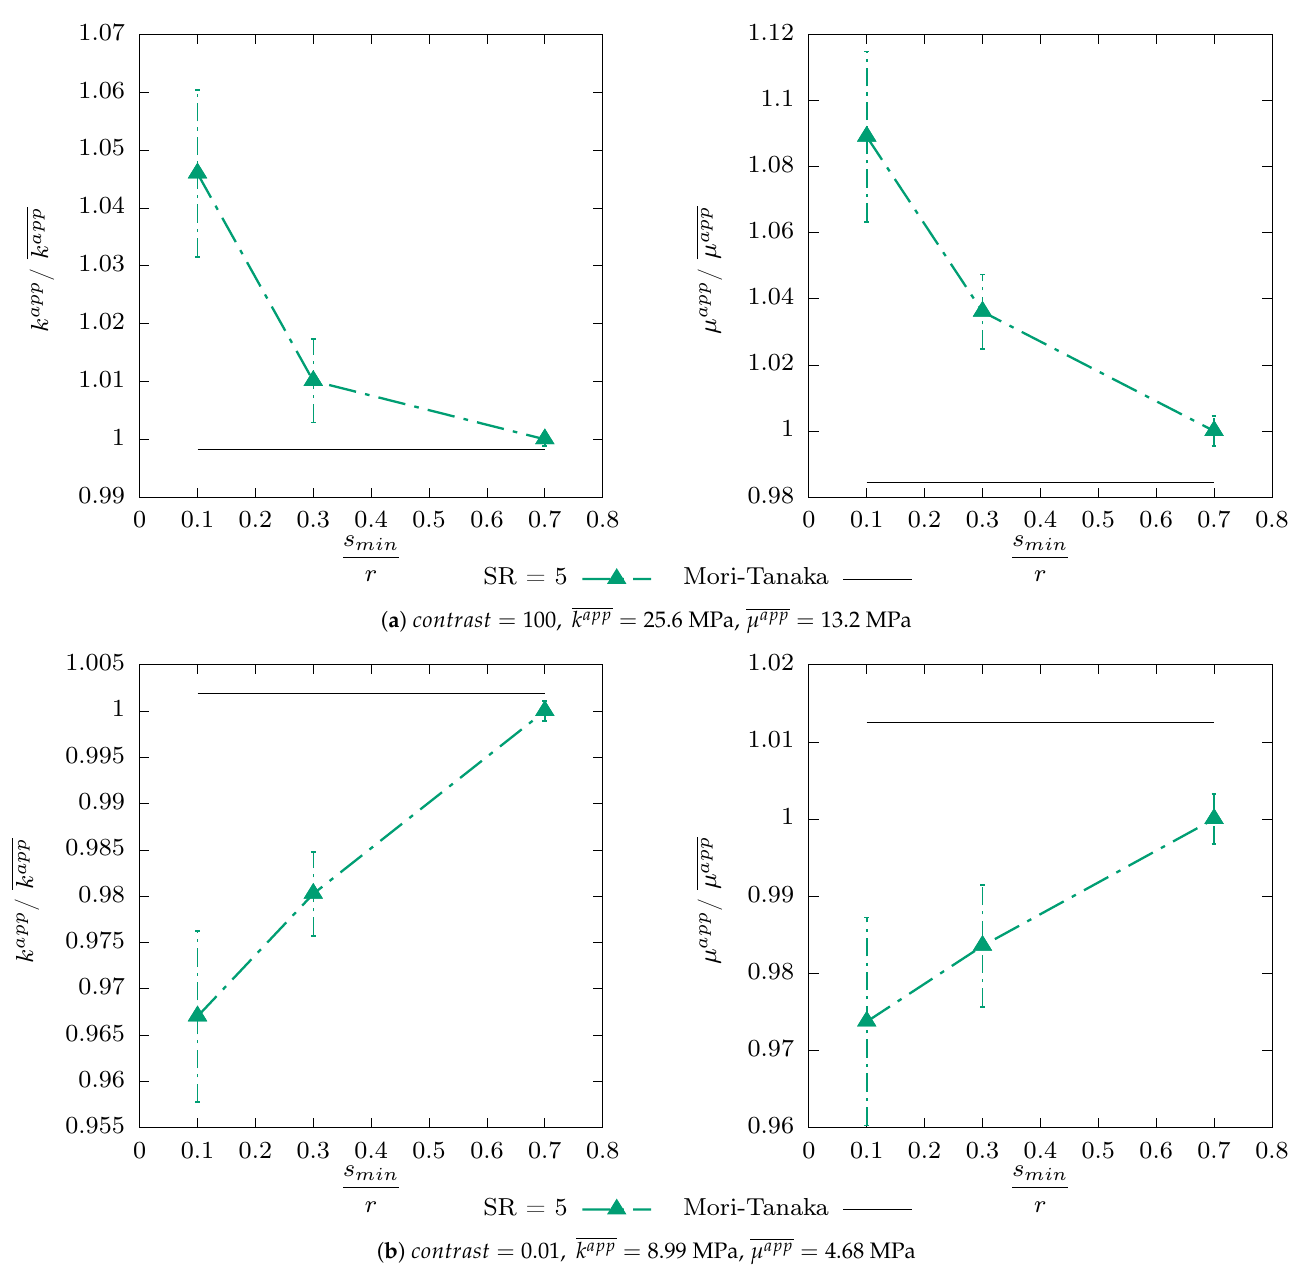
Figure 4. Mean values and standard deviations on the mean value for the apparent moduli as a function of the packing parameter s min / r ( r = 10 µ m) for a volume fraction of inclusions f v = 25.1